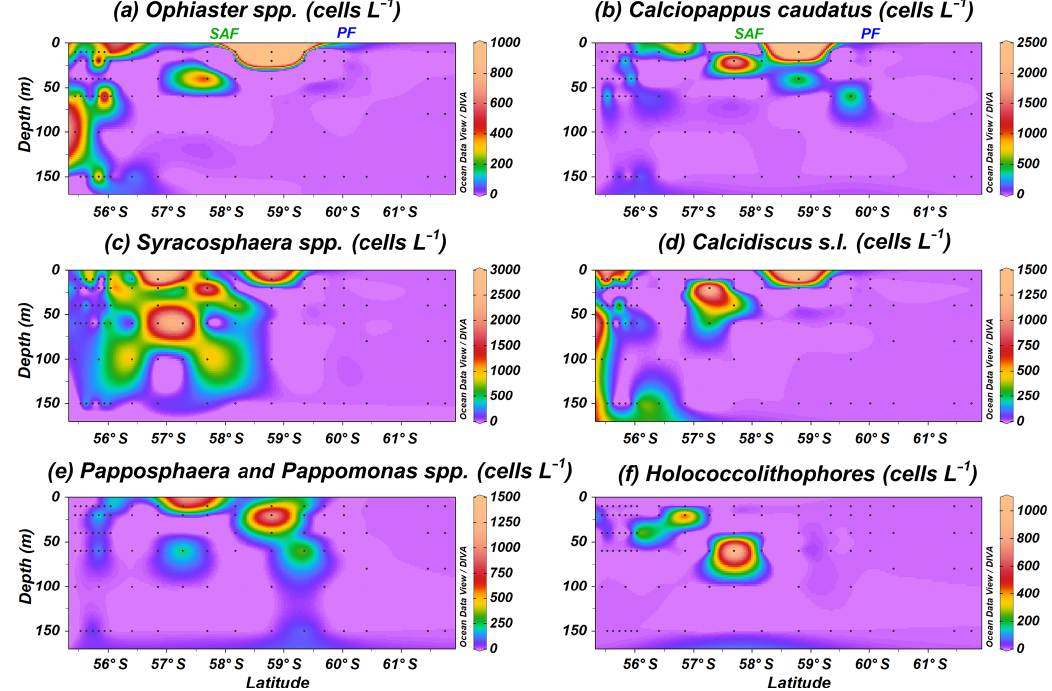
Figure 6. Location of the PS97 CTD stations studied, showing the number of coccospheres per litre of (a) Ophiaster spp., (b) Calciopap- pus caudatus , (c) Syracosphaera spp., (d) Calcidiscus s.l., (e) Papposphaera sp. and Pappomonas spp., and (f) holococcolithophores. The Subantarctic Front (SAF) and the Polar Front (PF), according to Orsi et al. (1995), are